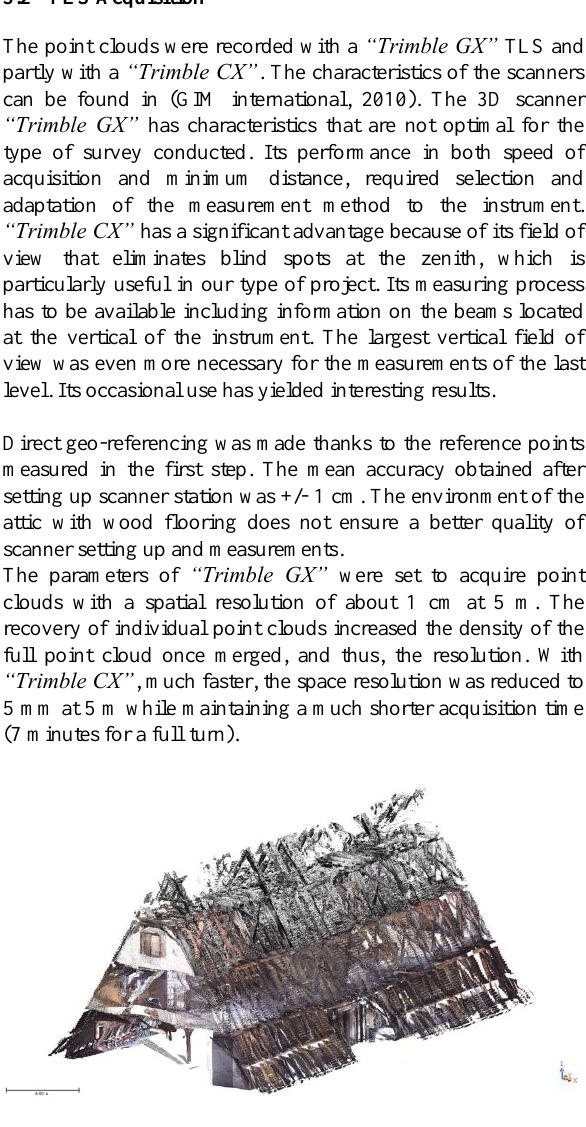
Figure 4: Merged point